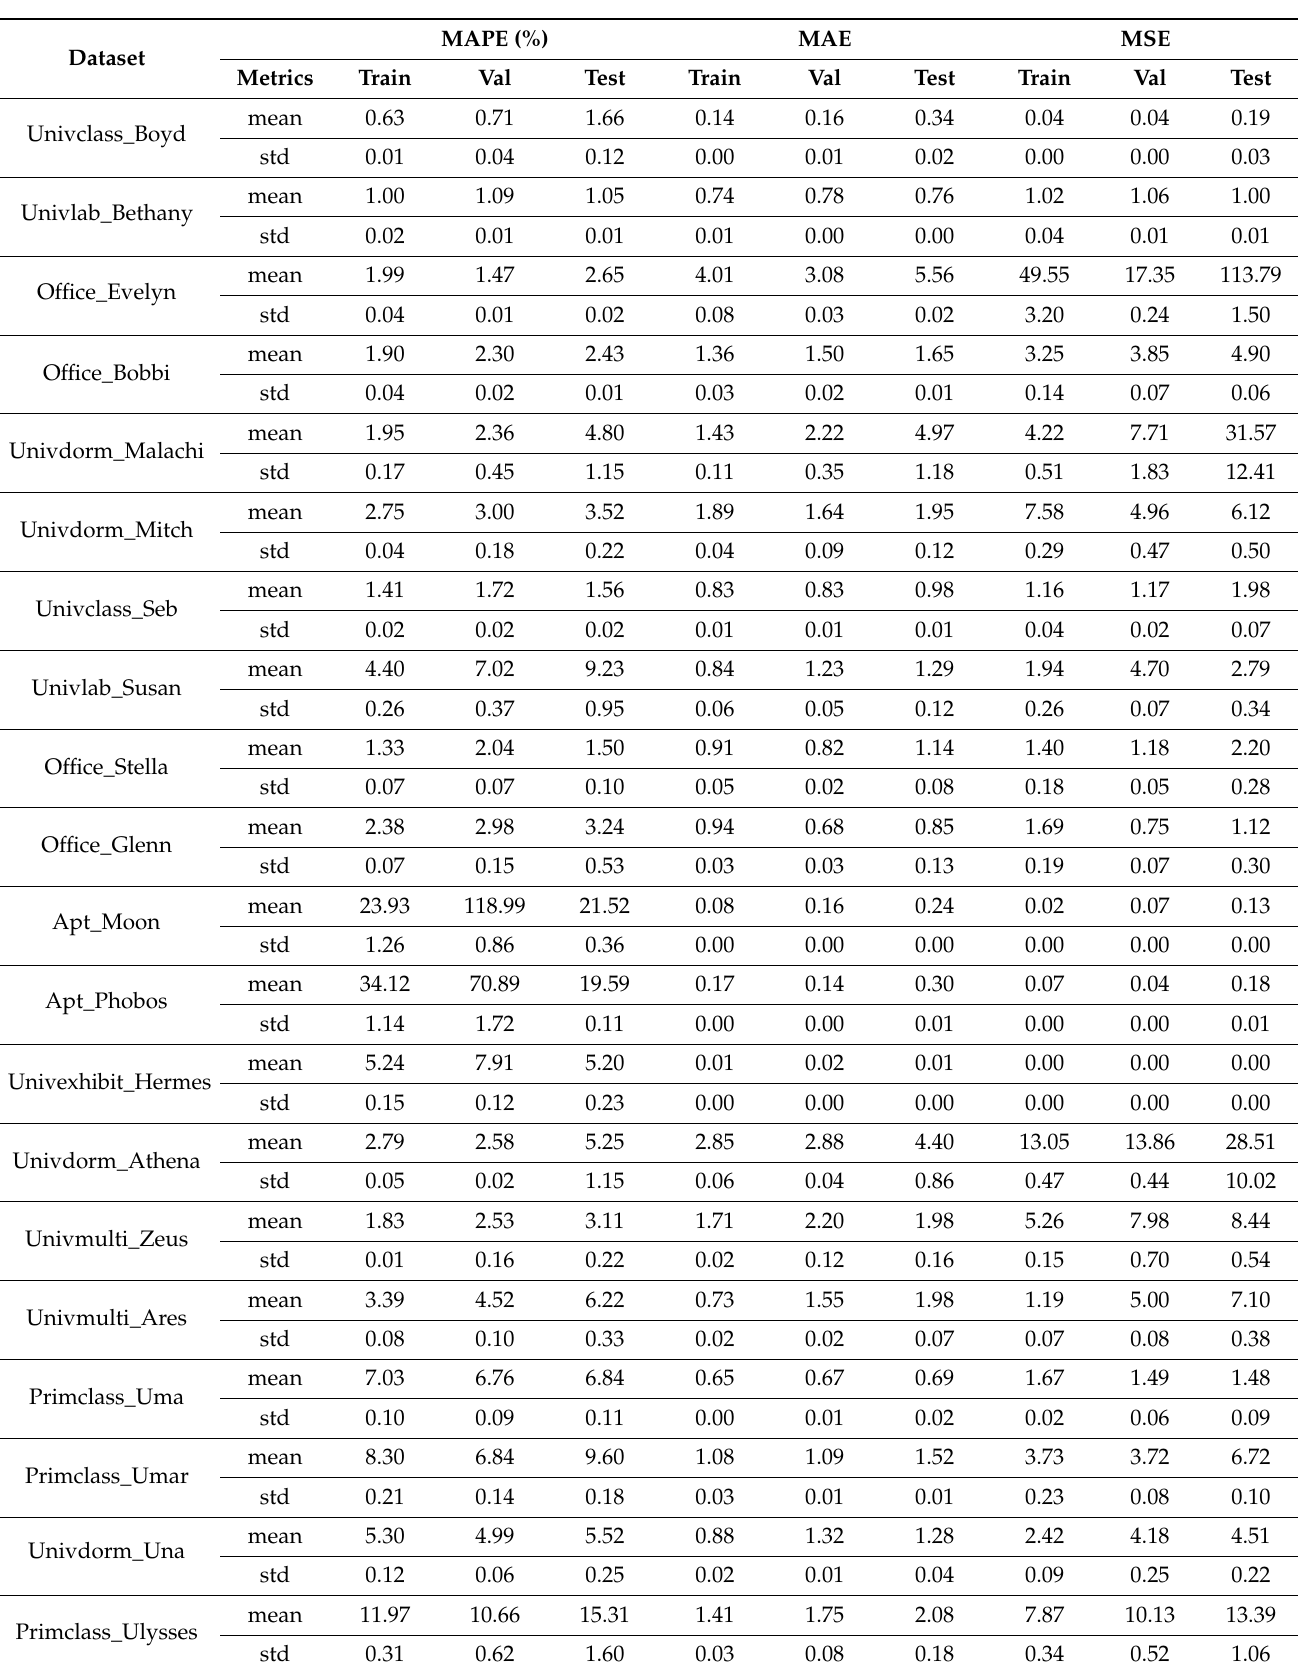
Table 9. The MAPE, MSE, and MAE of forecasting using EEMD-LSTM